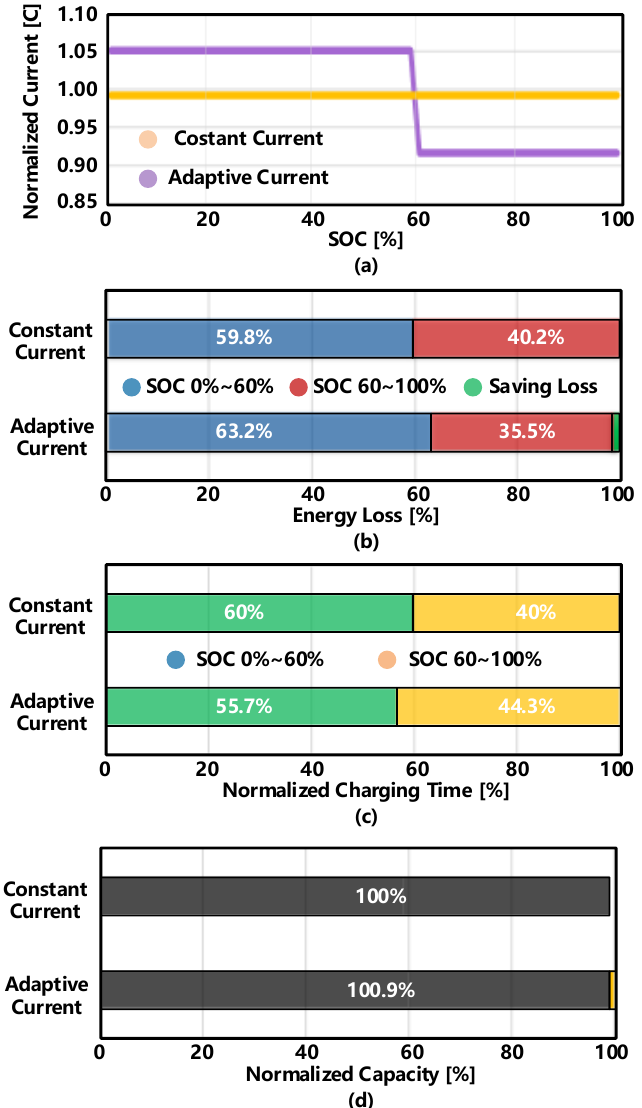
Figure 8. Example of the multistage current charging method. ( a ) Sets of normalized charging currents for the multistage current charging method. ( b ) Energy consumption comparison by charging method. ( c ) Charging time comparison by charging method. ( d ) Normalized capacity comparison by charging method.